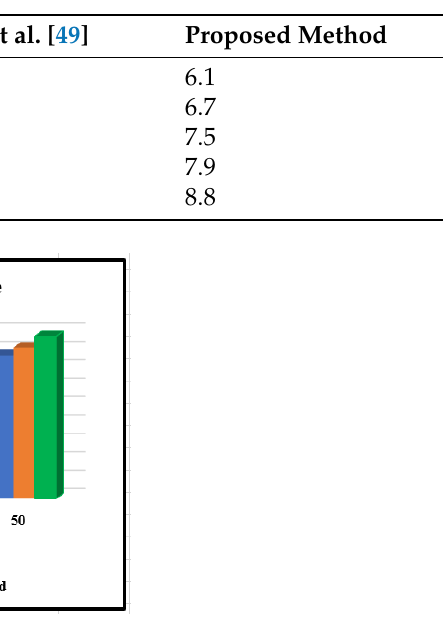
Table 6. Comparison of key generation time in IoT device.